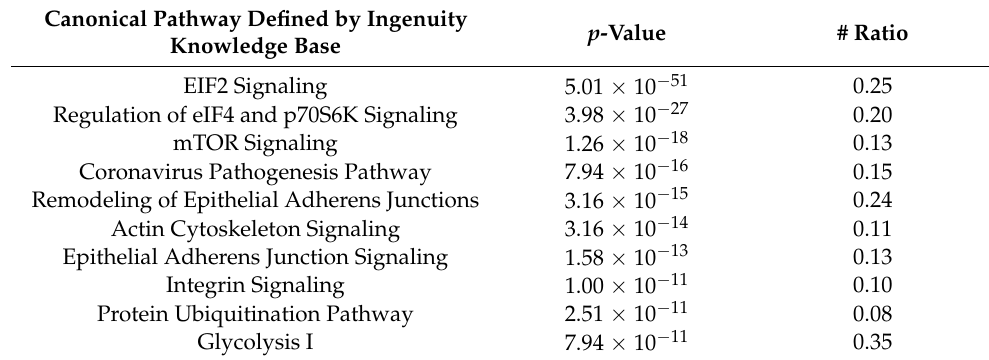
Table 2. The top ten canonical pathways identified using the list of 398 common proteins from three biological samples of canine in vitro oviductal cell-derived extracellular vesicles.